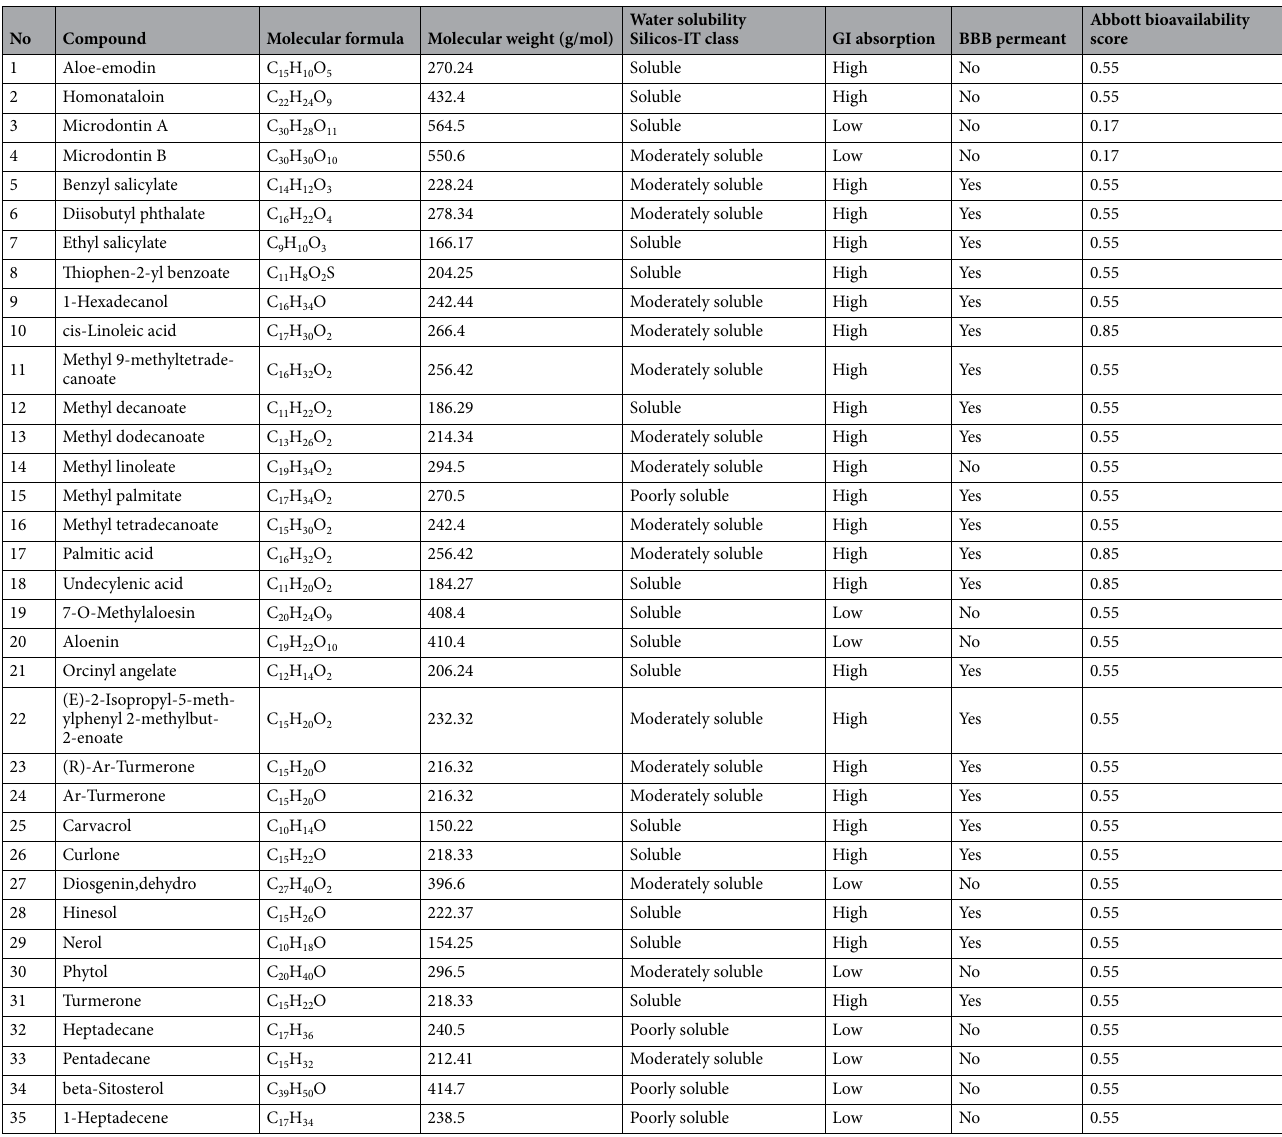
Table 2. Calculated physicochemical properties of Ethiopian indigenous aloes’